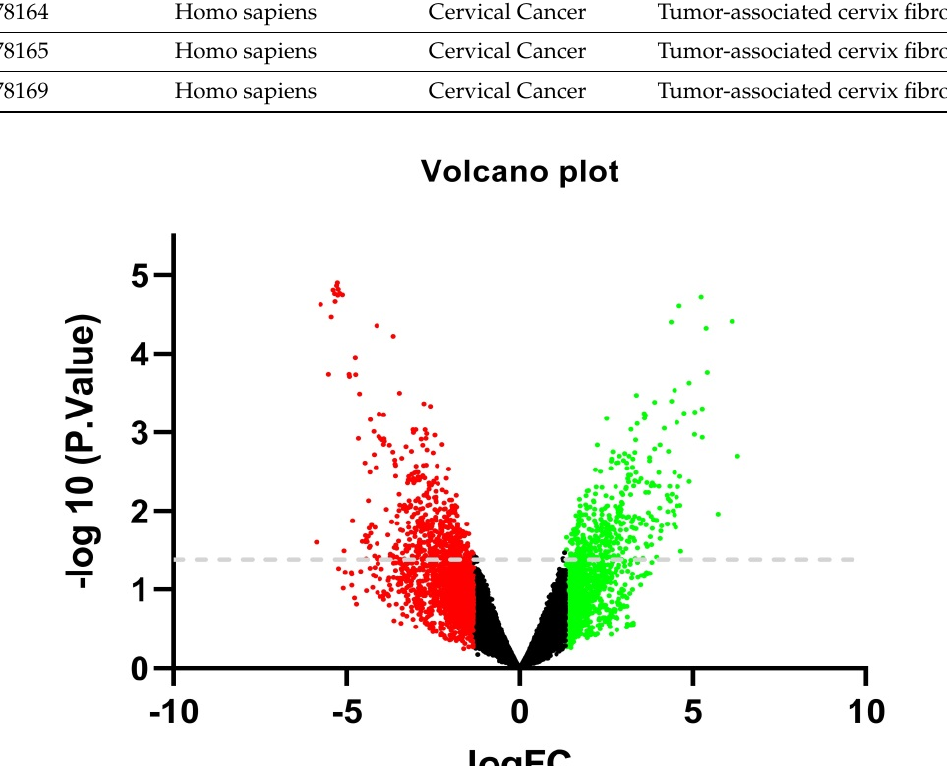
Figure 2. Volcano plot of the DEGs from the GSE148747 dataset. X-axis: logFC, large-scale fold changes; y-axis: -log10 of the p -value is showing the statistical significance. The green points represent the up-regulated genes while red points are for the down-regulated genes.